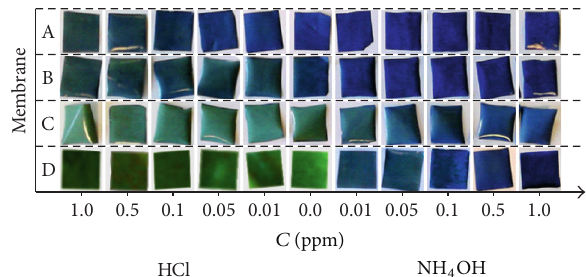
Figure 8: Effect of pH of the solution on the coloration of the PAN/PANI